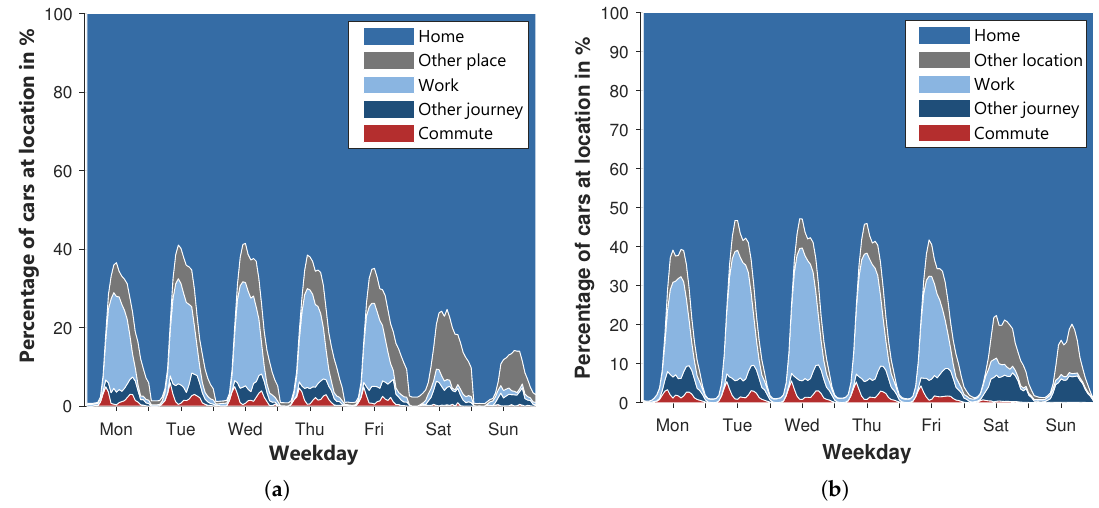
Figure 13. Layered percentage of cars at locations over the week: ( a ) MiD, ( b )